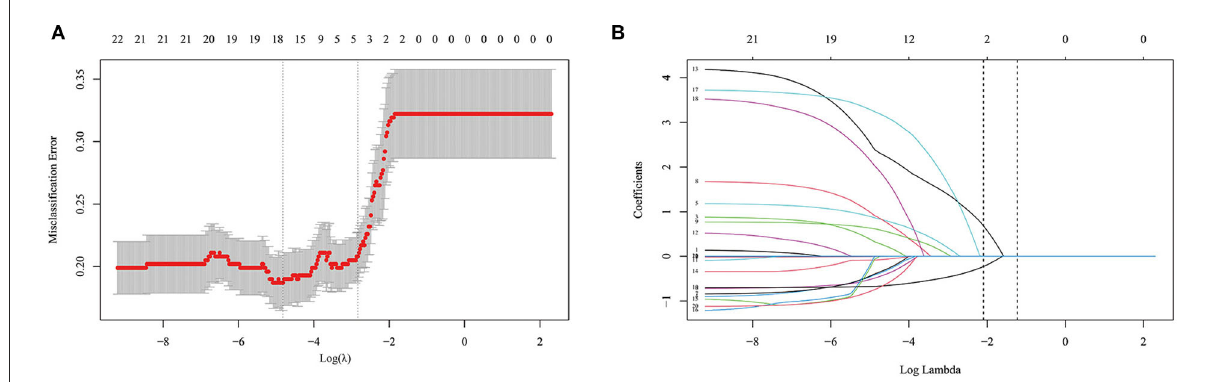
FIGURE1 Selection of optimal variables by least absolute shrinkage and selection operator (LASSO) analysis. (A) The selection of optimal parameters (lambda) by 10-fold cross-validation. (B) The vertical line was plotted at the optimal λ of 0.058, with log ( λ ) = − 2.834. Four factors with non-zero coefficients were finally selected.